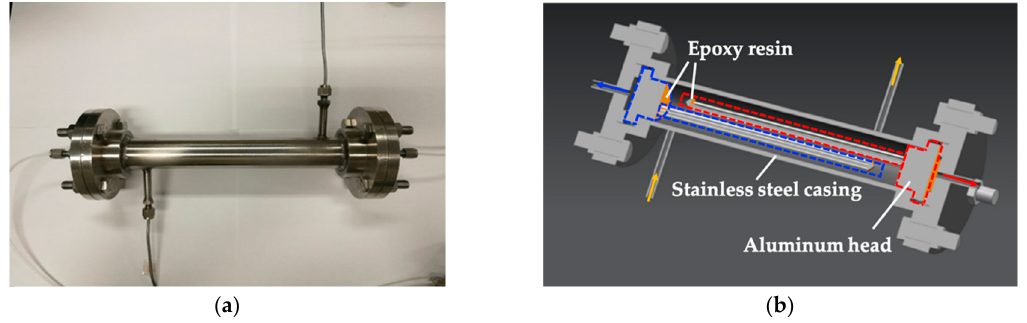
Figure 1. Dual membrane separator ( a ) Appearance of dual membrane separator; ( b ) internal structure diagram.